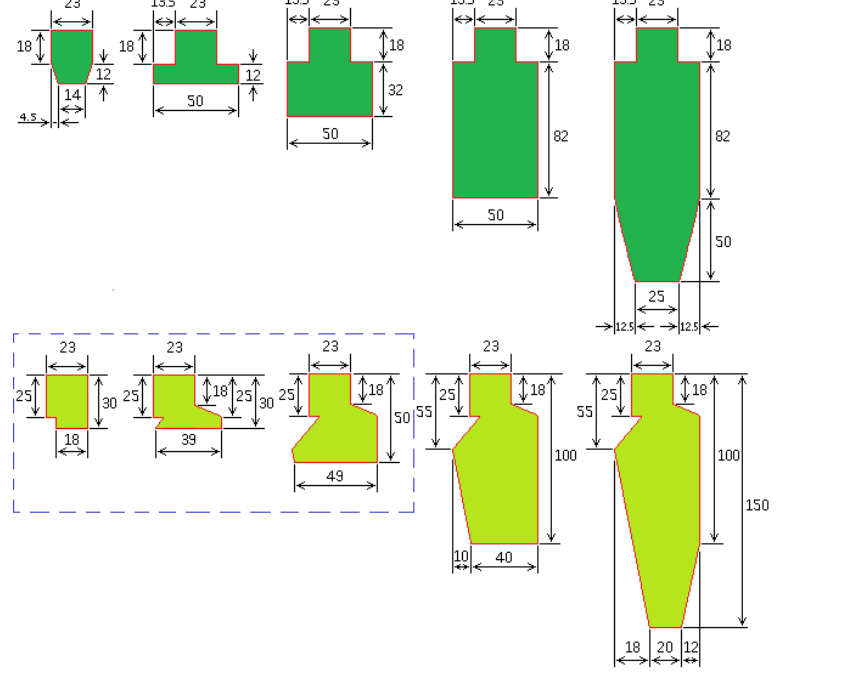
Figure 1 – Silhouettes of five FRATs (top row) and five FLATs (bottom row) Рис . 1 – Силуэты пяти фронтально атакующих ( верхний ряд ) и флангово